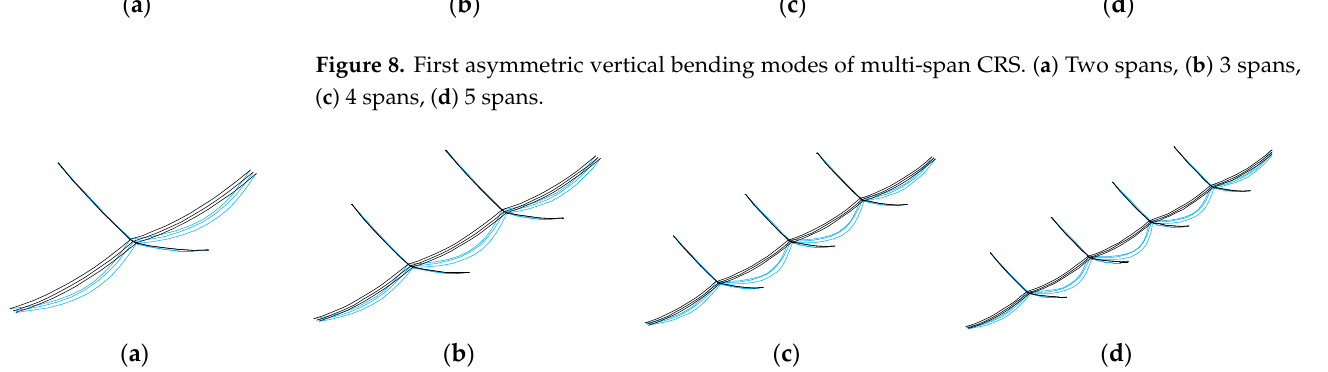
Figure 9. First symmetric lateral bending modes of multi-span CRS. ( a ) Two spans, ( b ) 3 spans, ( c ) 4 spans, ( d ) 5 spans.